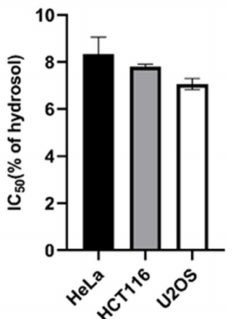
Figure 1. Antiproliferative activity of H. perforatum ssp. veronense determined by MTS-based cell proliferation assay. Statistical analysis was performed using one-way ANOVA followed by Turkey’s multiple comparison test. Error bars indicate the standard deviation of triplicate